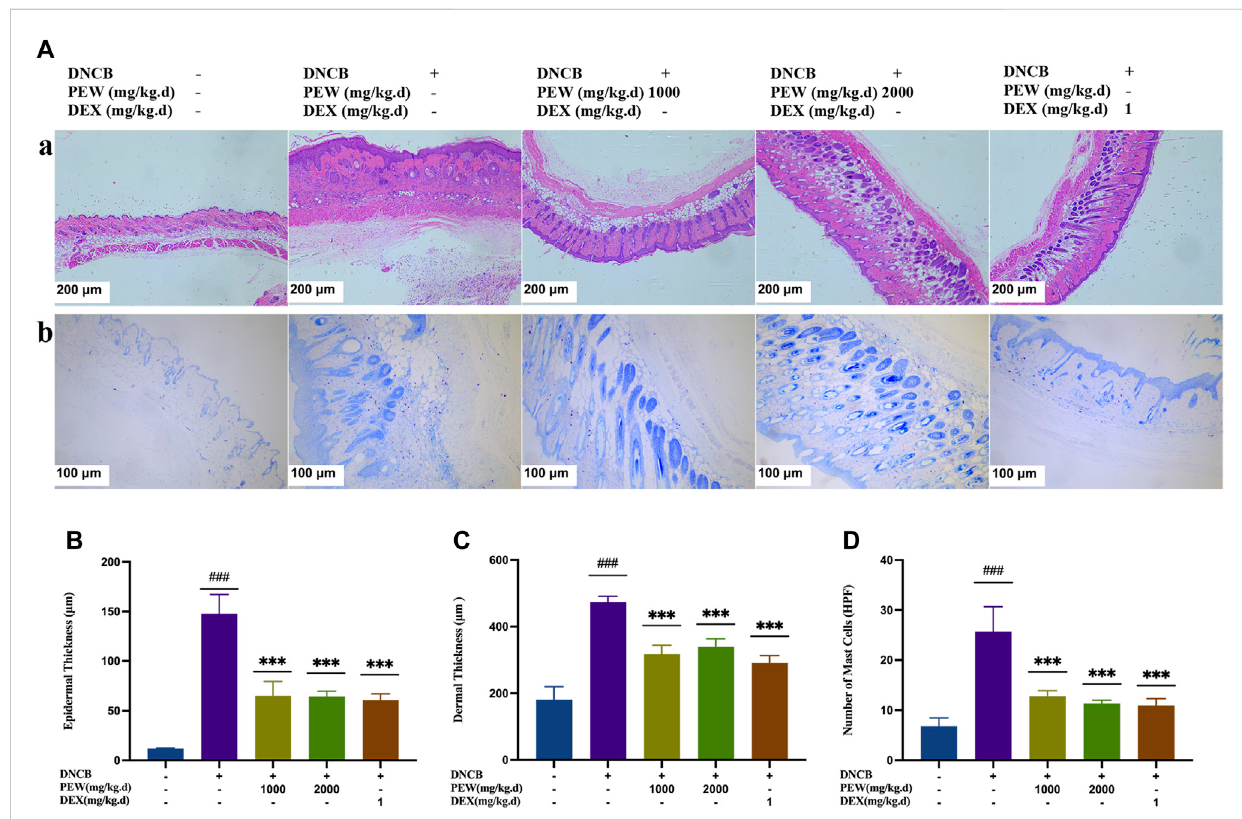
FIGURE 3 Effects of PEW on histopathological features of dorsal skin lesions in DNCB-induced Balb/c mice. (A) Representative images of histological examination (dorsal skin); (a) H&E staining (50×, scale bar = 200 μ m); (b) toluidine blue staining (100×, scale bar = 100 μ m). (B) Epidermal thickness ( n = 5 – 6/group). (C) Dermal thickness ( n = 5 – 6/group). (D) The number of mast cells ( n = 5 – 6/group). The data were presented as means ± SD. ### p < 0.001, VS. the normal group; *** p < 0.001, VS. the model control group.